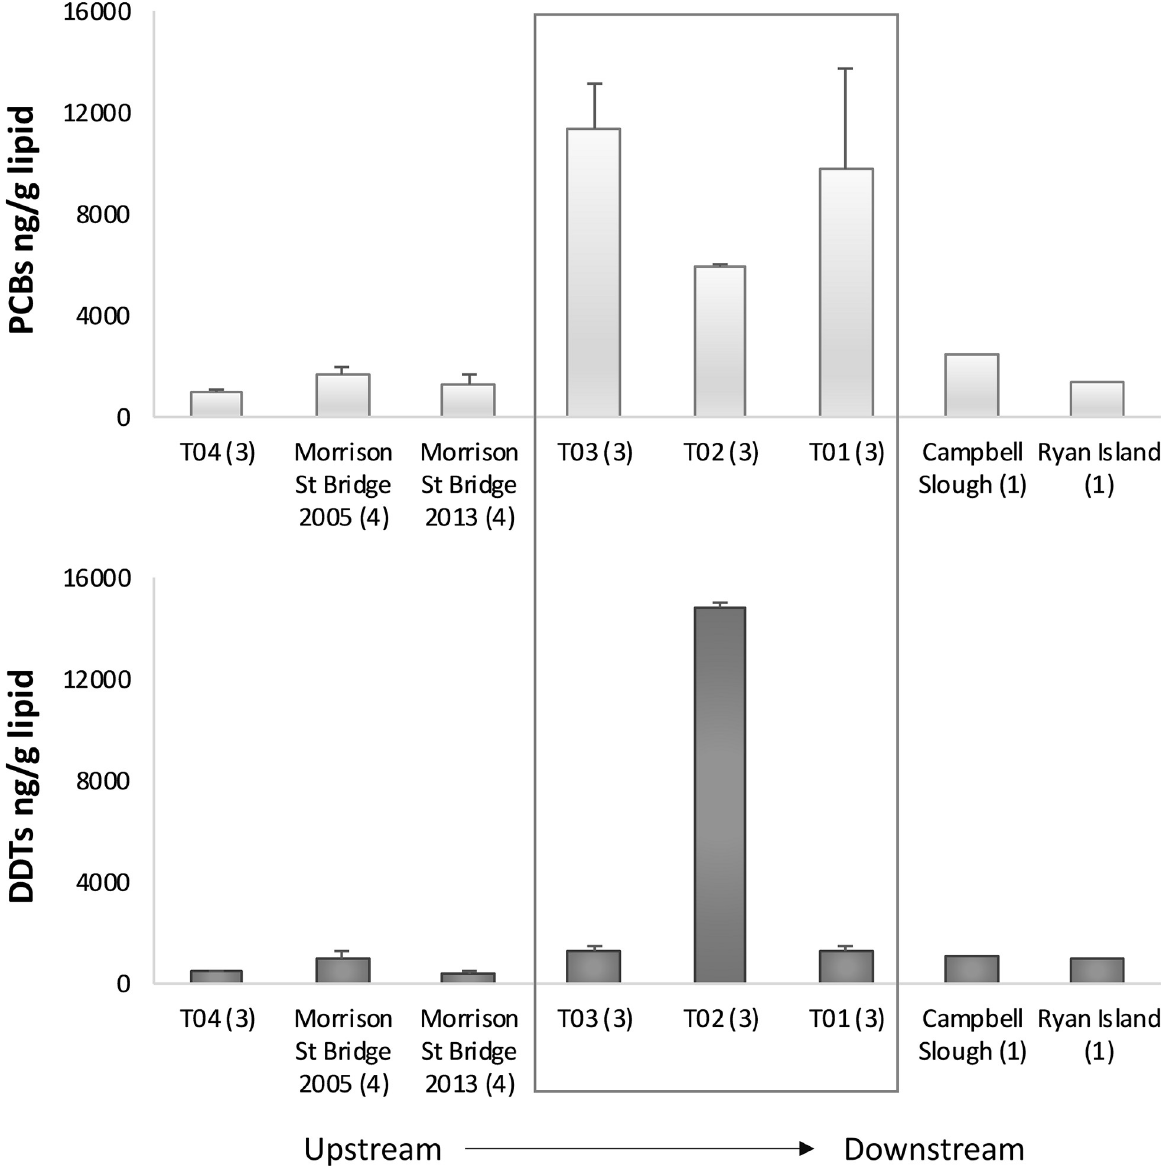
Fig 3. Measured persistent organic pollutants (PCBs and DDTs) in the tissues of outmigrating UWR juvenile Chinook salmon [26, 27, 30]. Mean values from whole body composite samples (n), with the stomach contents removed, from three sites within Portland Harbor (box), two sites upstream, and two sites downstream. Error bars show standard deviation. For consistency across studies, PCBs reported as ∑ 17PCBs � 2 (PCBs 18, 28, 44, 52, 95, 101, 105, 118, 128, 138, 153, 170, 180, 187, 195, 206, 209); DDTs reported as ∑ 3DDTs (p,p’-DDD, p,p’-DDE, p,p’-DDT). Figure data and data for lipids, butyltins, and PAHs on S1